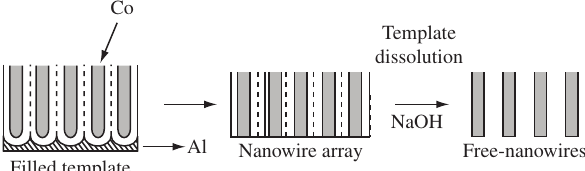
Figure 1. Template-method to obtain nanowires.